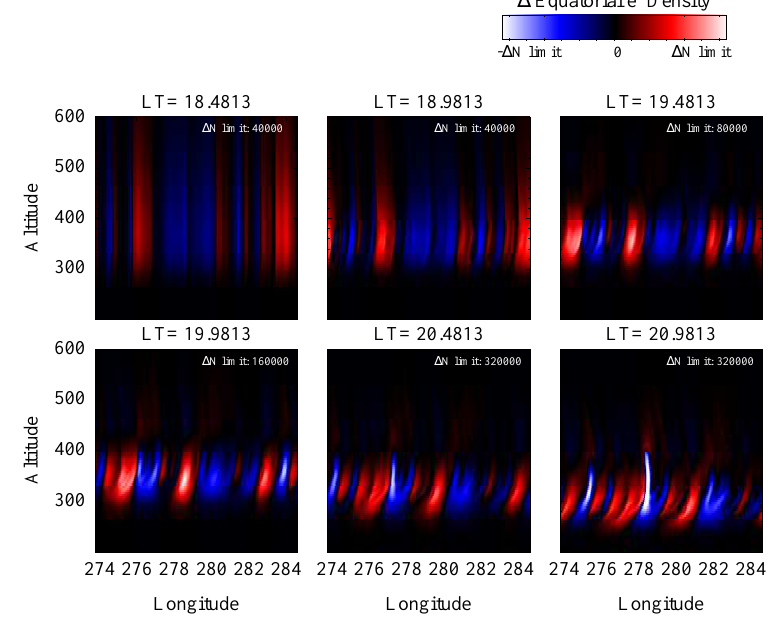
Fig. 12. Snapshots of the density perturbations taken at a sequence of times in a simulation in the plane of the geomagnetic equator as a function of longitude and apex altitude, beginning with the density perturbations observed by the C/NOFS satellite around 23.8 UT on day 281 of 2010 near magnetic longitude 280 ◦ . Note the changing scale from snapshot to snapshot for the density perturbations (permitted to vary to capture all the variations of the density); the magnitude of the limits of the range of density perturbations (in number percm 3 ) spanned by the color bar are indicated in each panel. In this case, plumes do develop.